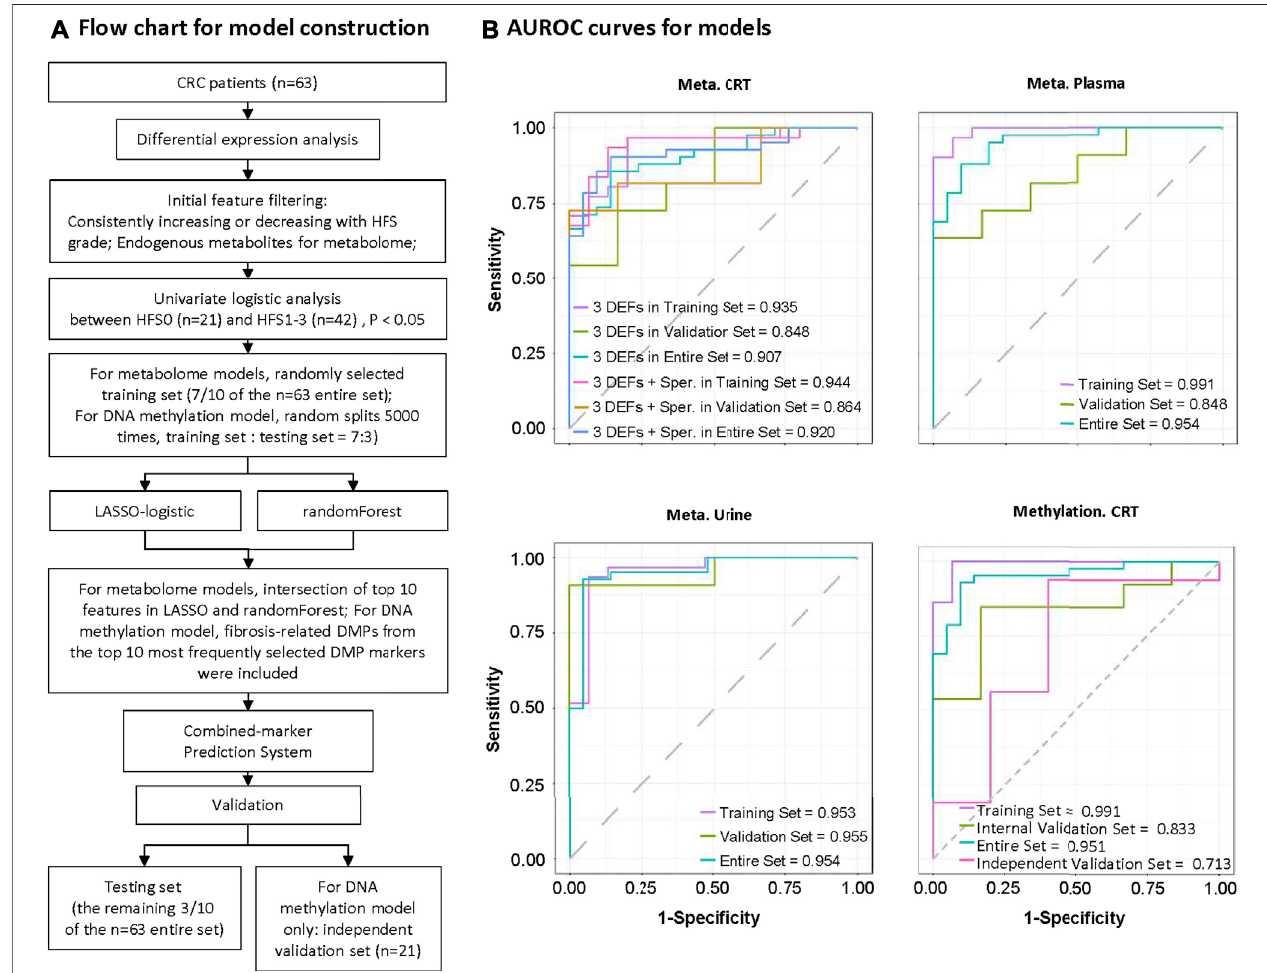
FIGURE 8 | Construction of potential marker systems for HFS prediction. (A) Flow chart for model construction. The entire set was used to identify differentially expressed features (DEFs) in each omics dataset. During model development, we randomly divided the samples into training and validation sets (7:3). Models were developed to discriminate CRC patients who did not experience HFS (HFS0) from those with HFS (HFS:HFS1, HFS2/3). Models were constructed based on CRT metabolome, plasma metabolome, urine metabolome, and CRT methylation, respectively. (B) Respective ROC (receiver operating characteristic) curves for the developed models in thetraining set, validation set, and entire set. Note: Independent validation wasperformed for CRTmethylation only. Abbreviation:Sper, spermine.